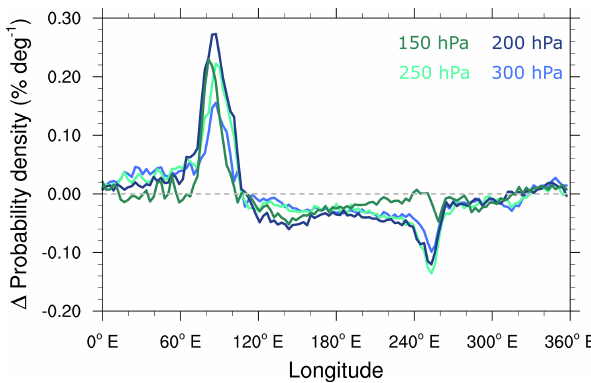
Figure 16. Difference (August minus June) of longitudinal proba- bility densities of parcels that originate from the TP at various pres- sure levels in the UT based on 1981–2010 for the LG-D